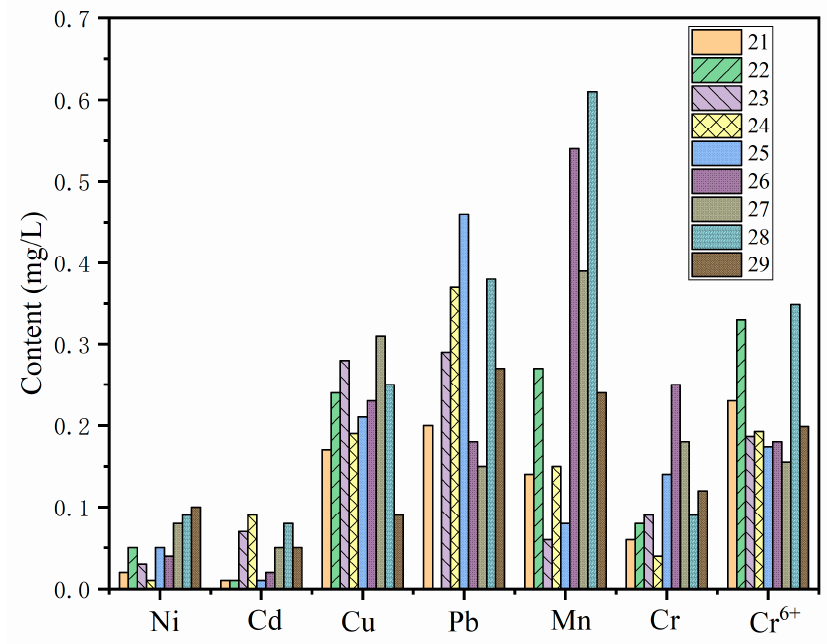
Figure 10. Leaching toxicity of heavy metals.